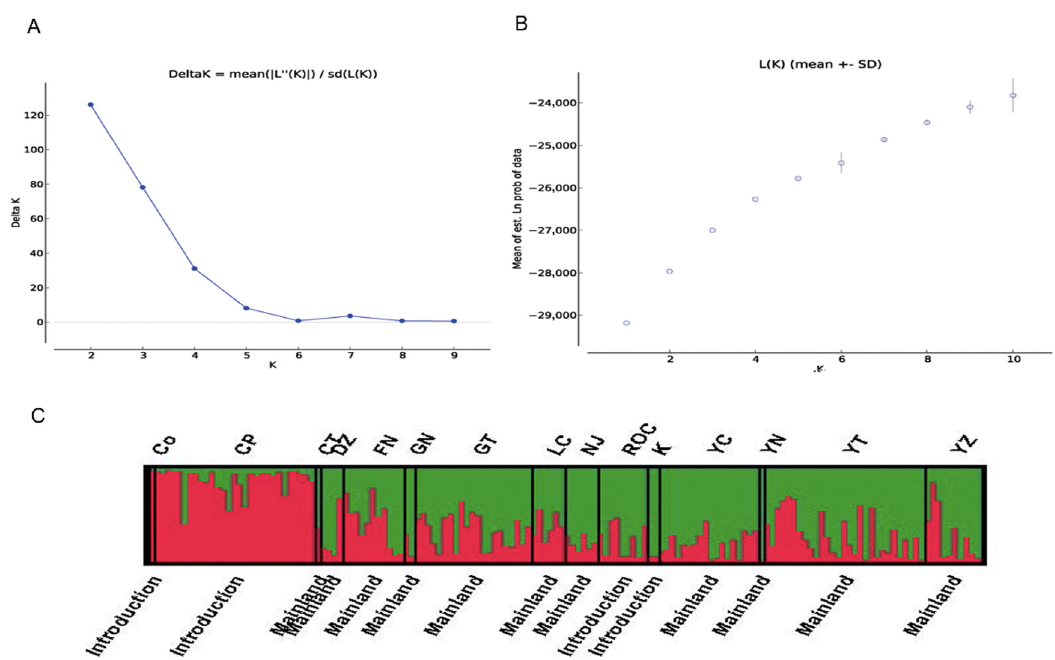
Figure 1. ( A ) Delta K ( ∆ K ) for di ff erent numbers of subpopulations ( K ); ( B ) average log-likelihood K -value (LnP( K )) against the number of K ; ( C ) the population structure of 150 most popular parental clones in the hybrid breeding programs in China based on the distribution of 226 SSR alleles among these clones. Pop1 clones are coded in red and Pop2 clones in green.